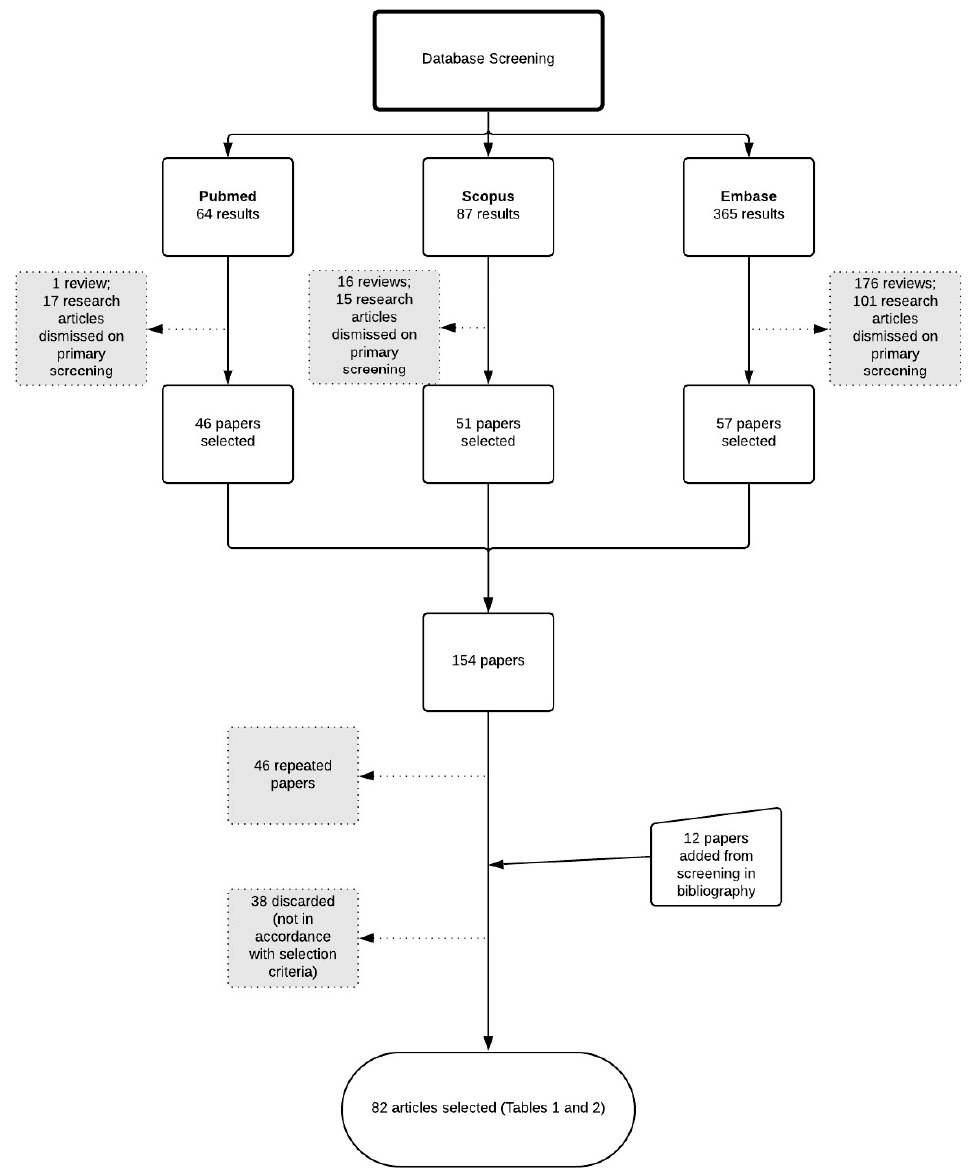
Figure 1. Flowchart representing the steps of literature survey and selection of research papers.